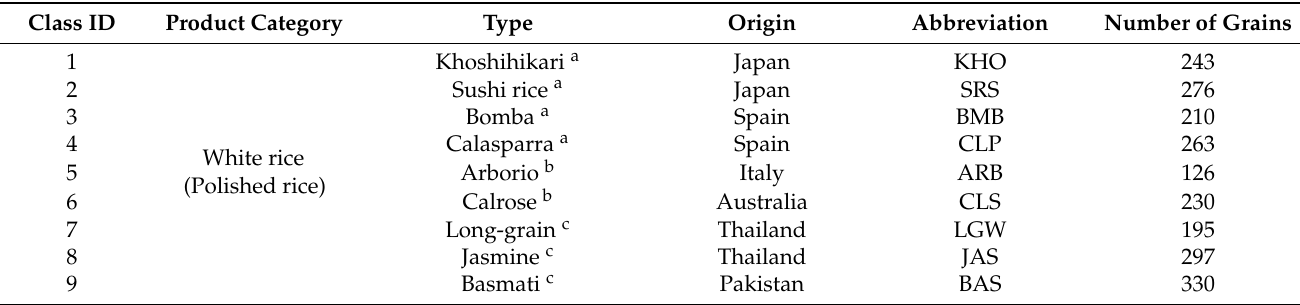
Table 1. Details of commercial rice samples, including class ID, product category, type, origin, abbreviation, and the number of grains per rice type in triplicates obtained using Lightbox